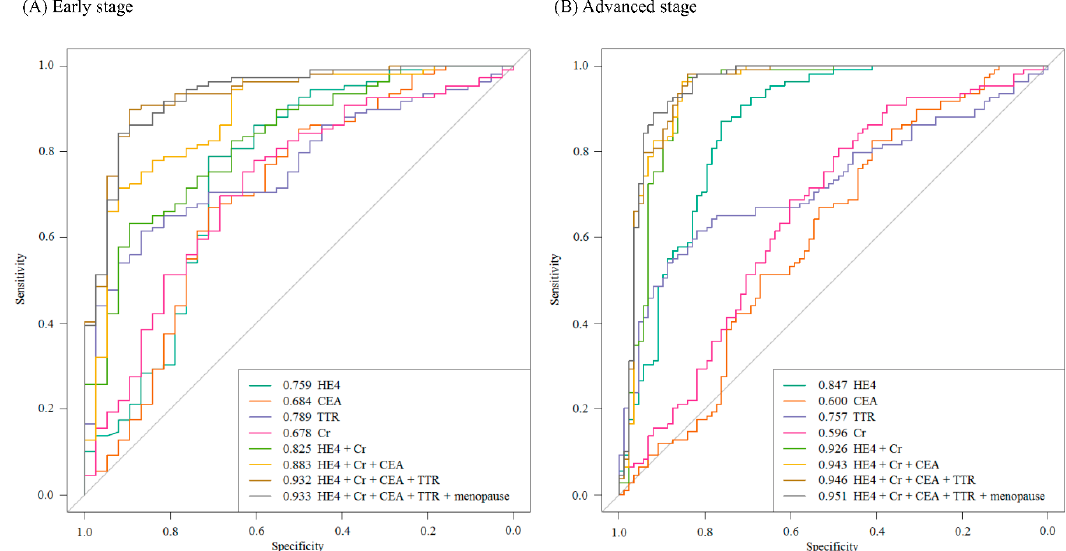
Figure 4. The ROC curve of multimarker panels (i.e., HE4, creatinine, CEA, and TTR) according to the FIGO stage, and the results from the addition of menopausal status.